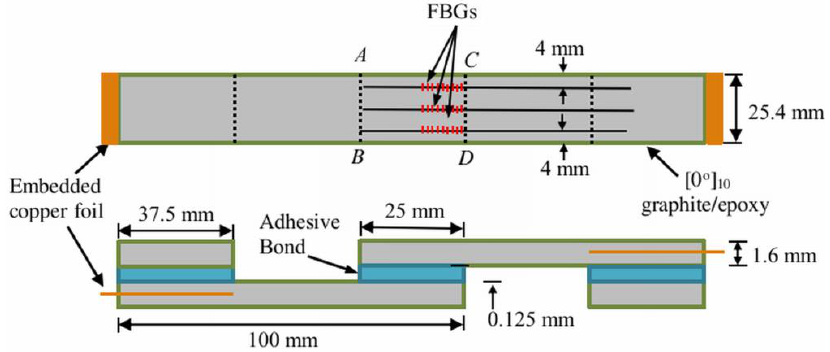
Figure 1. Dimensions and layout of the single lap joint specimen.